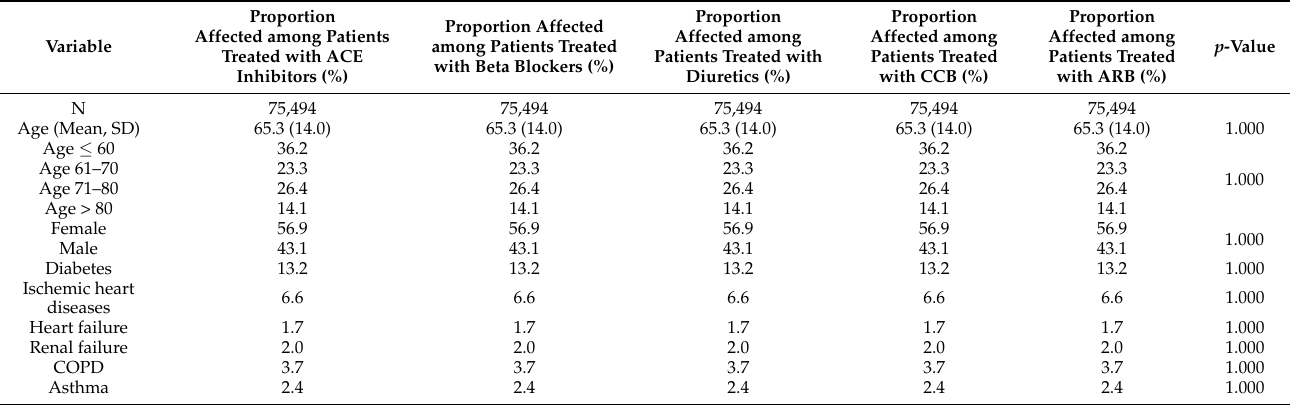
Table 1. Basic characteristics of the study sample after propensity score